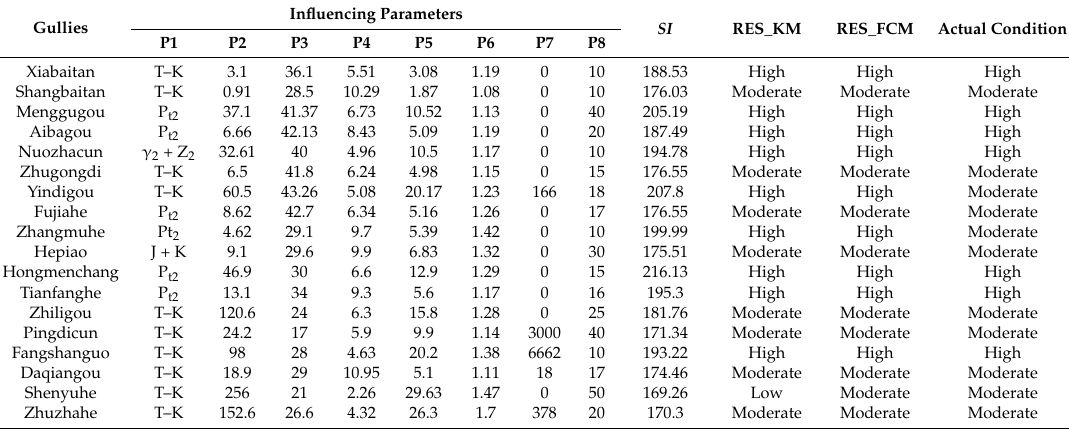
Table 5. Susceptibility assessment results of the 22 debris flow gullies.